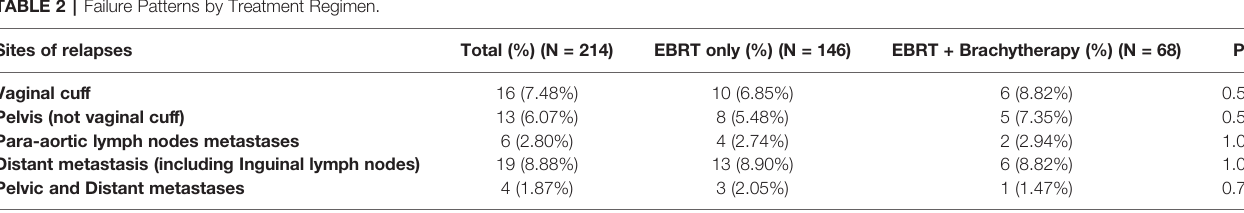
TABLE 2 | Failure Patterns by Treatment